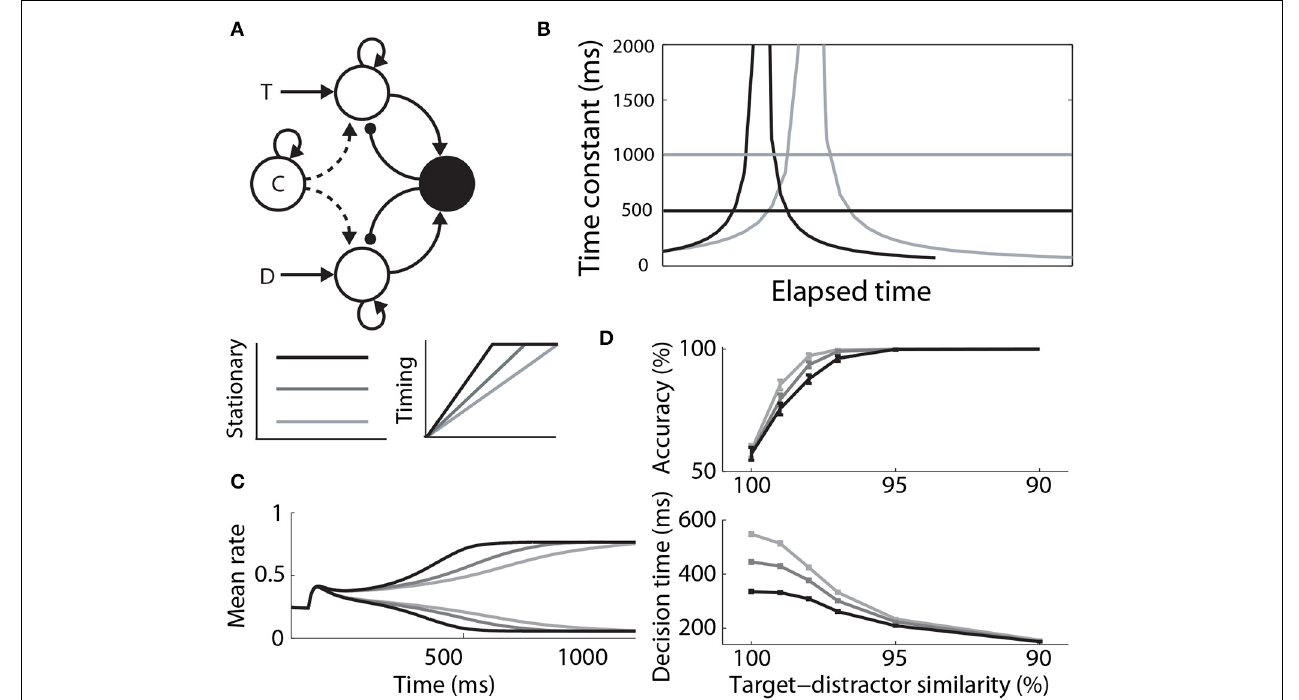
FIGURE 7 | (A) A control signal (c) modulating local-circuit decision processing. The signal could be implemented by persistent, goal directed activity (Stationary) or by climbing activity, encoding elapsed time relative to a deadline (Timing). The model schematic is the same as in Figure 3A , with the addition of the control signal. (B) Under stationary modulation, the decision network can support a single time constant of integration for a given trial, depicted by the horizontal lines. A stronger control signal furnishes a shorter time constant. Under time-dependent modulation, the time constant of